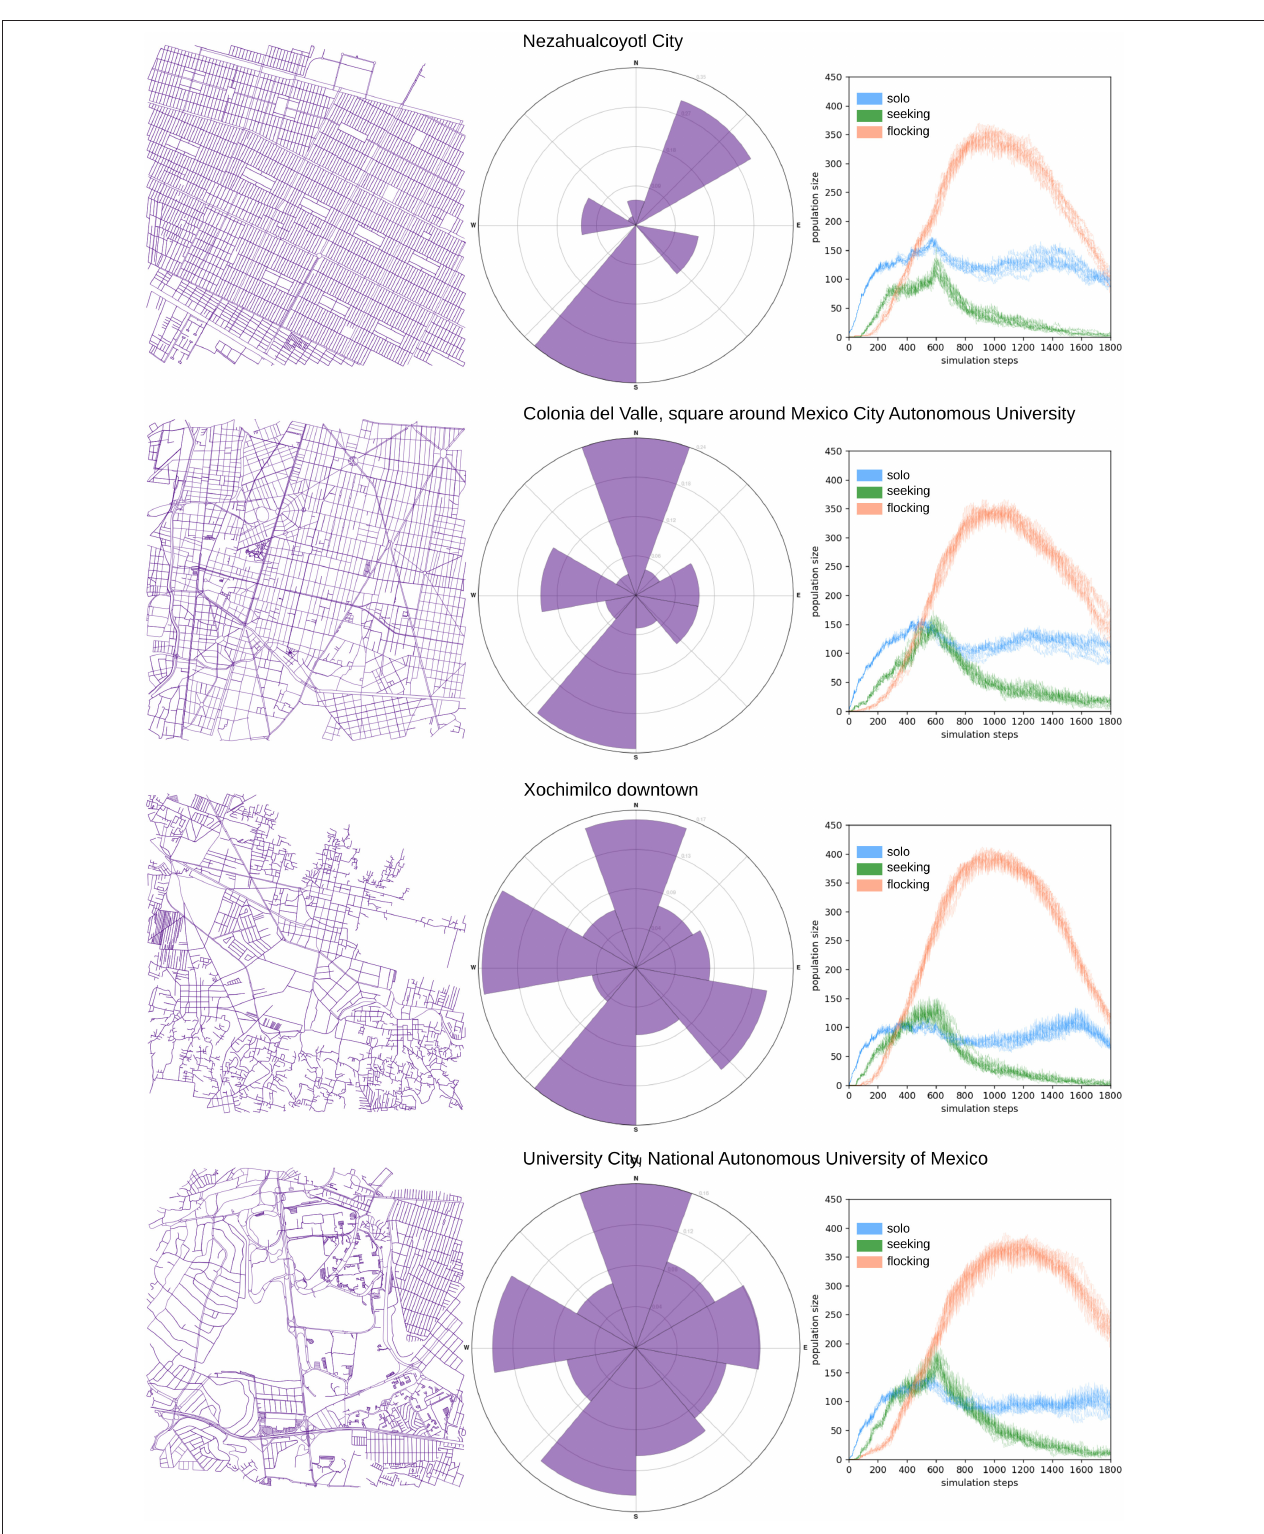
FIGURE 5 | Simulations were run in these squares. Radial histograms show street orientation frequencies, as a measure of spatial order. Population dynamics are plotted on the rightmost column, and show that flock formation is robust to the layout of streets.